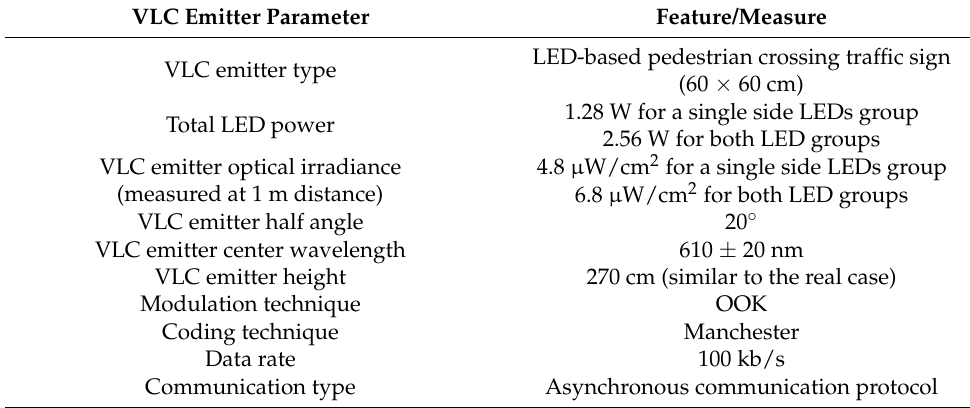
Table 2. Visible light communications emitter